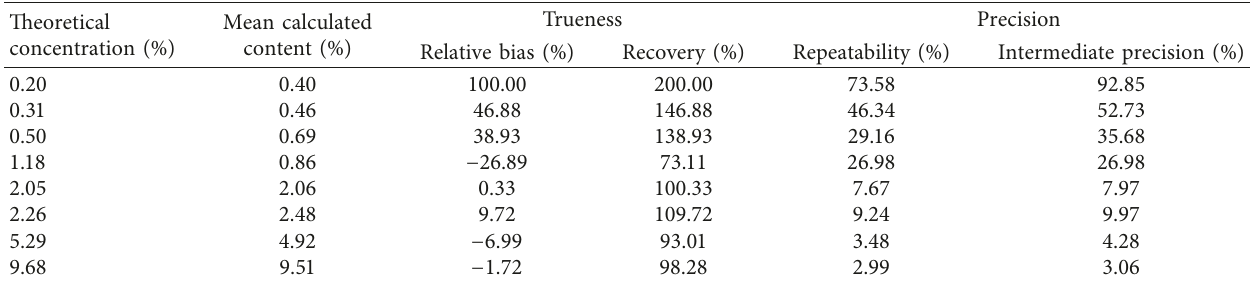
Table 4: The validation results of NIR determination of tanshinoneII